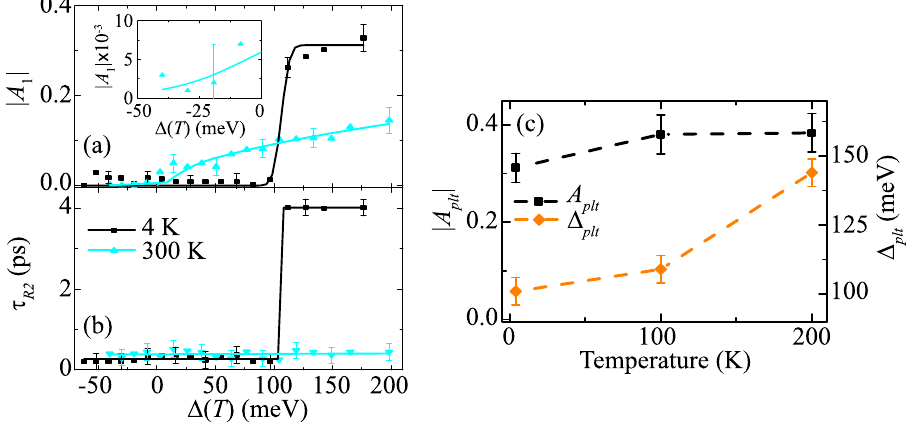
Figure 3. Excess-photon energy dependent of ( a ) | A 1 | and ( b ) τ R 2 from the fitted transients for 4 K and 300 K, revealing a plateau in the former. The inset in ( a ) shows the below band gap response of | A 1 |(300 K). ( c ) Temperature dependence (up to 200 K) of the magnitude for the fast decay mechanism | A plt | (black squares) and for the excess energy onset of plateau Δ plt (orange diamonds).